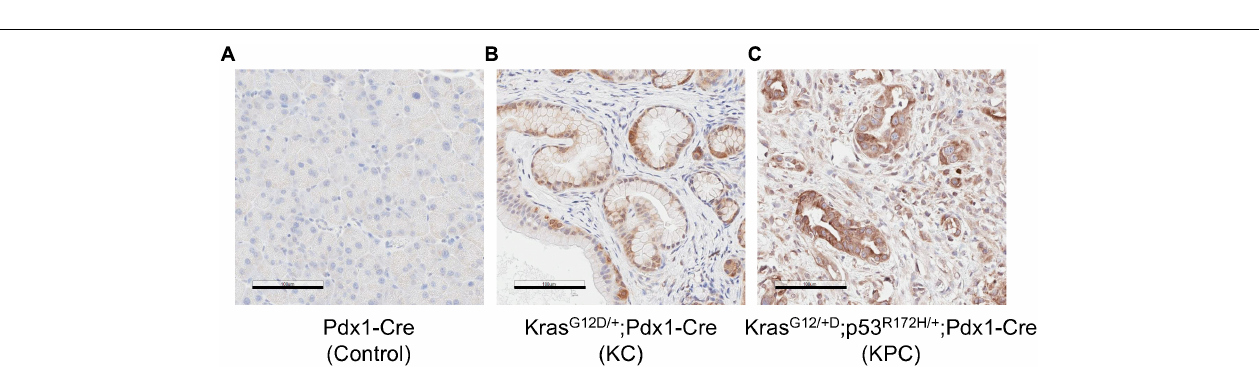
FIGURE 4 | Matriptase expression is upregulated in PanIN, primary PDAC and liver metastasis. IHC analysis of normal human pancreatic tissues using anti-matriptase antibody. Representative staining images are shown. (A) Normal pancreas, PanIN1/2, PanIN 3, and PDAC; (B) Specimen of pancreatic cancer liver metastasis. The areas of the tumor and the adjacent tumor are indicated. Magnification: 4 × (left panel) or 20 × ; Scale bar: 500 (left panel) or 100 µ m.